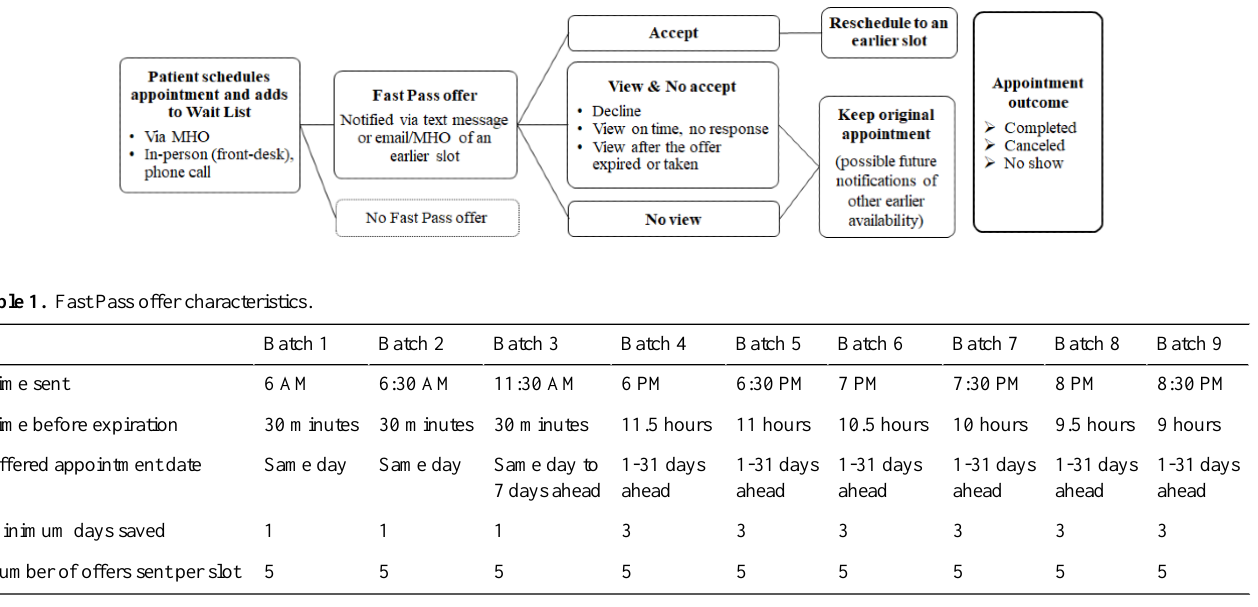
Figure 1. Flow of scheduling, rescheduling, and appointment outcomes with Fast Pass. MHO: My Health Online.